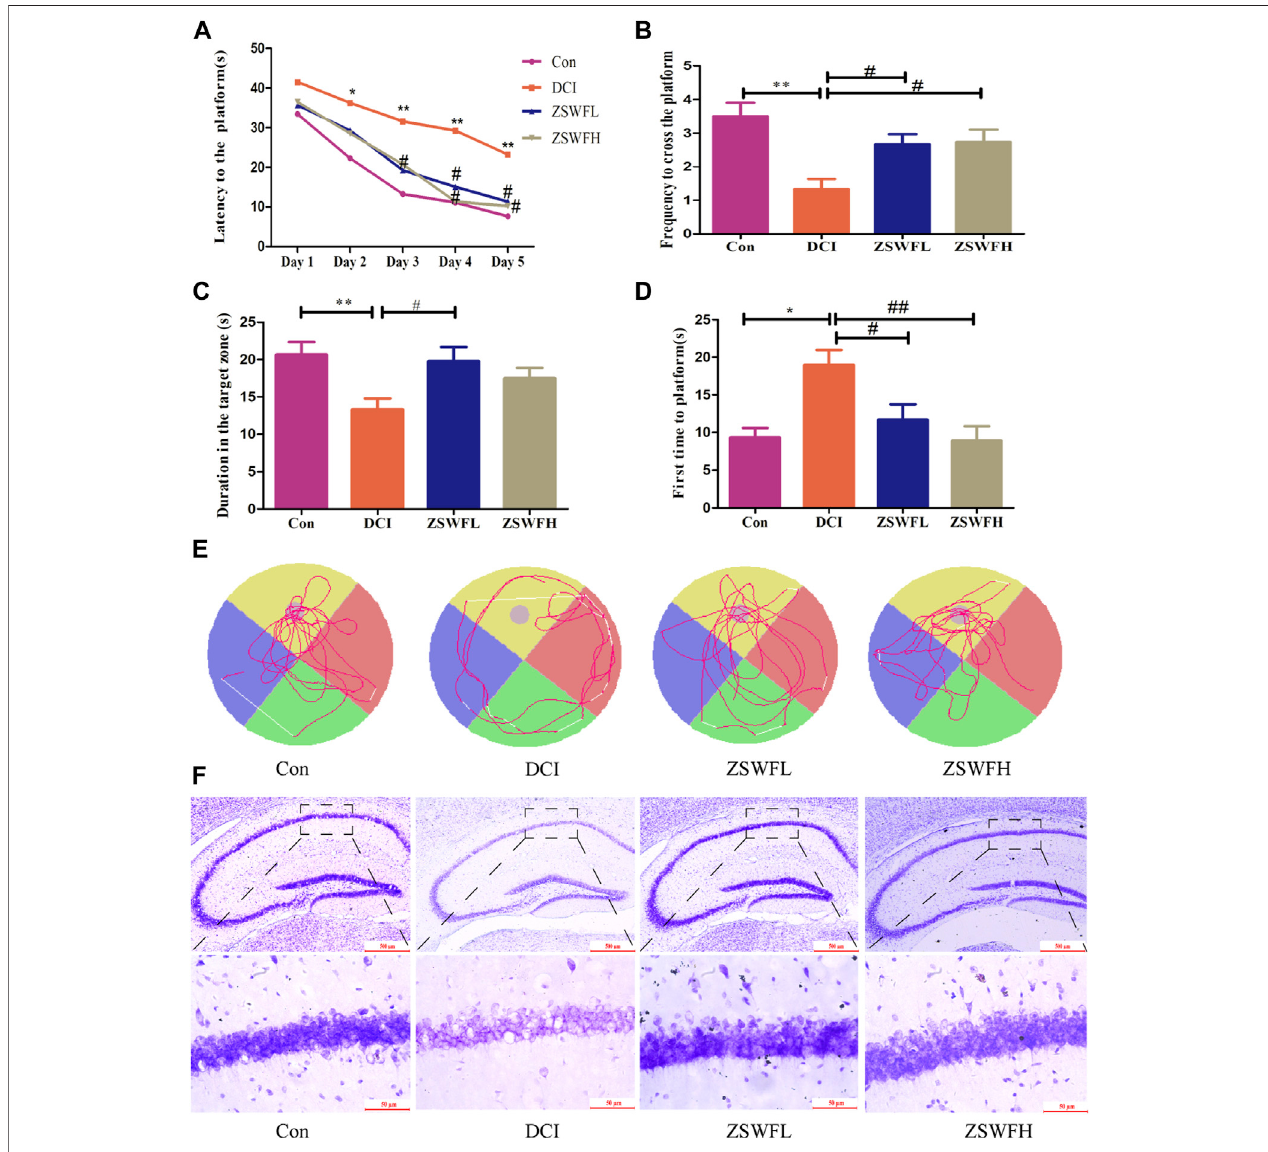
FIGURE1| ZSWFamelioratedcognitiveimpairmentandpreventedneurondamageinDCImice. (A) escapelatency, (B) thefrequencyofcrossingtheplatform, (C) duration in the platform quadrant, (D) time of fi rst arrival at platform. These data are expressed as the mean ± SD, ( n = 15). Escape latency data were analyzed by repeated measurement ANOVA, other data were analyzed by one-way ANOVA. ** p < 0.01, * p < 0.05 vs. Con group, ## p < 0.01, # p < 0.05 vs. DCI group. (E) representative swimming tracks of each group of mice in the space exploration experiment. (F) representative images of cresol violet staining in hippocampus of each group of